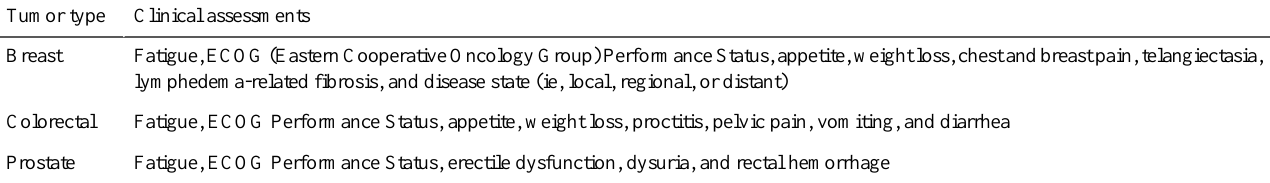
Table 1. Radiation oncology follow-up standardized clinical assessment. Clinical assessmentsTumor